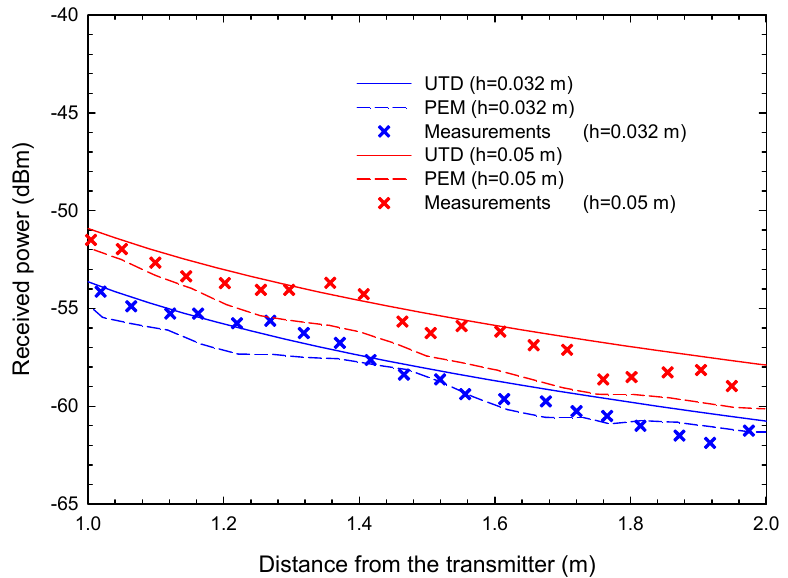
Figure 28. Comparison between the theoretical GO/UTD results for the LOS case (one obstacle) and the measurements presented in [8].